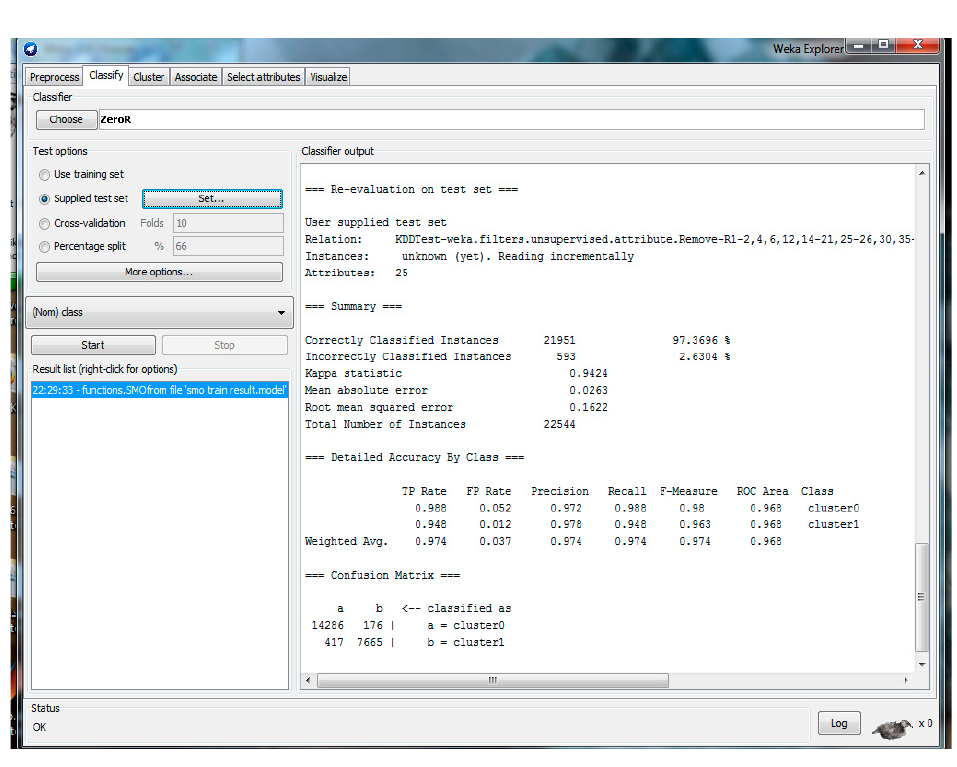
Figure 8. Results of using hybrid technique, i.e., K-mean, SMO, and dataset with 22 attributes. Table 8. Accuracy details for hybrid technique, i.e., K-mean and SMO parameters. TP Rate